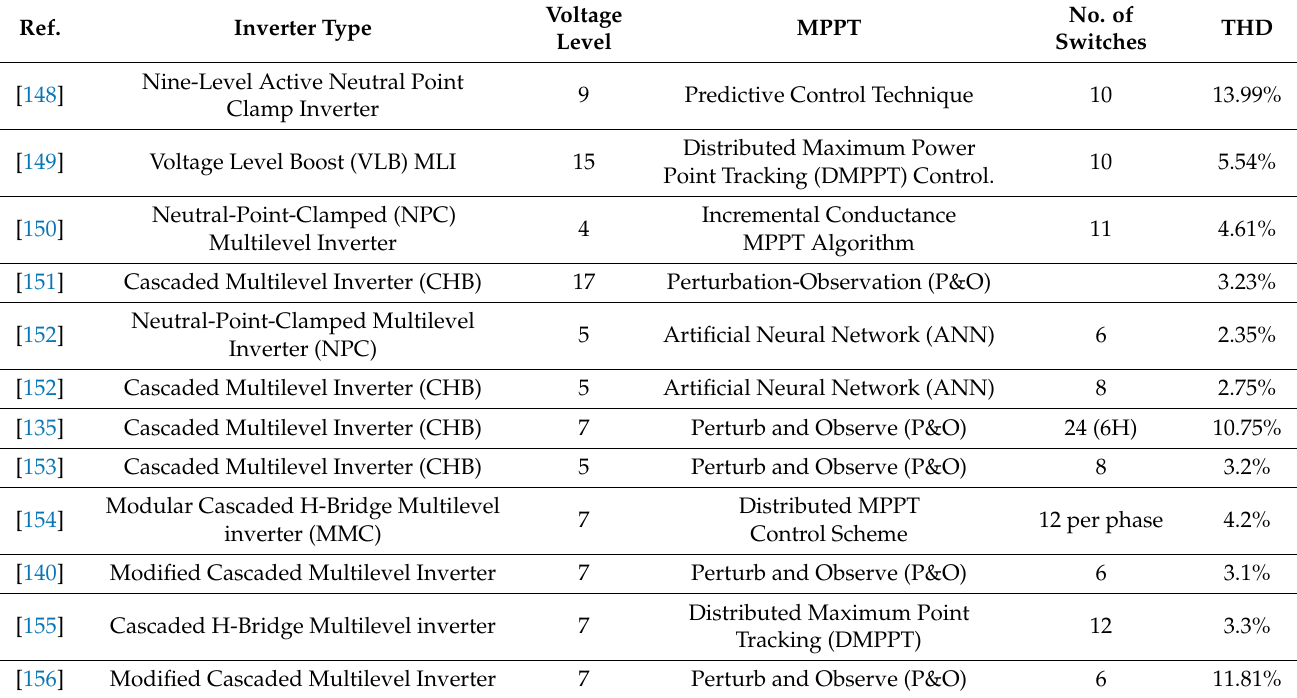
Table 2. A comparison of recent MLIs grid-connected PV systems in the literature.